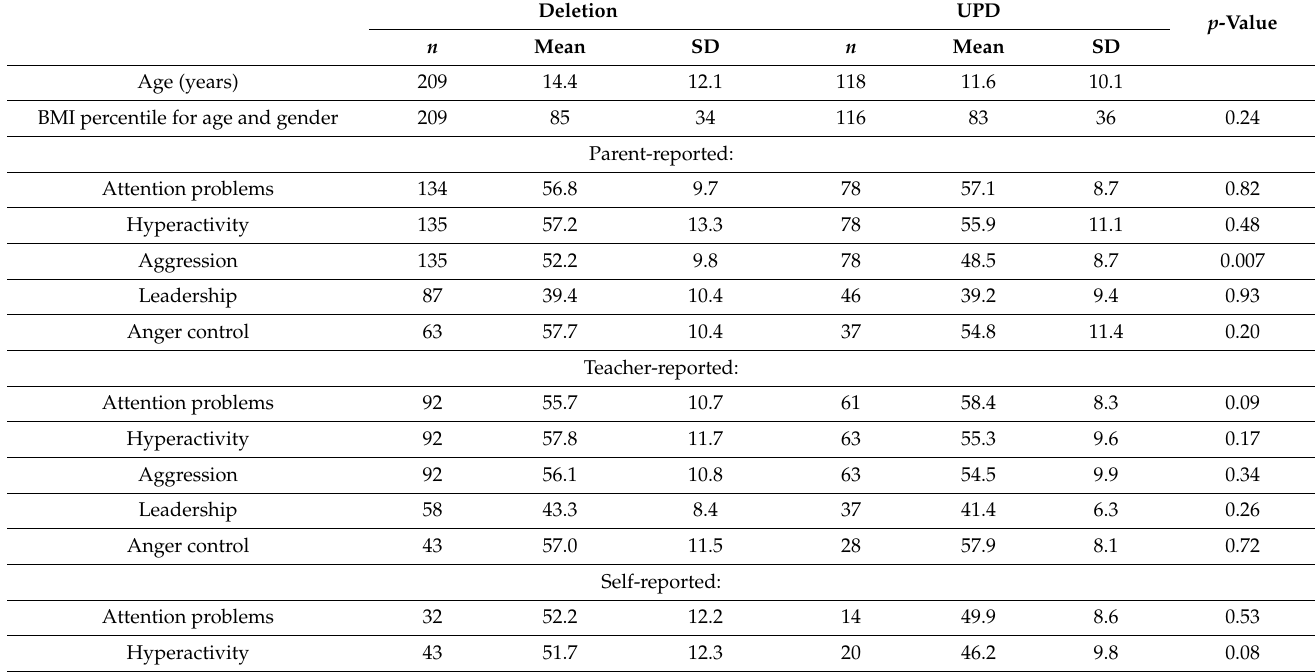
Table 2. Demographics and behavior assessments by molecular class.